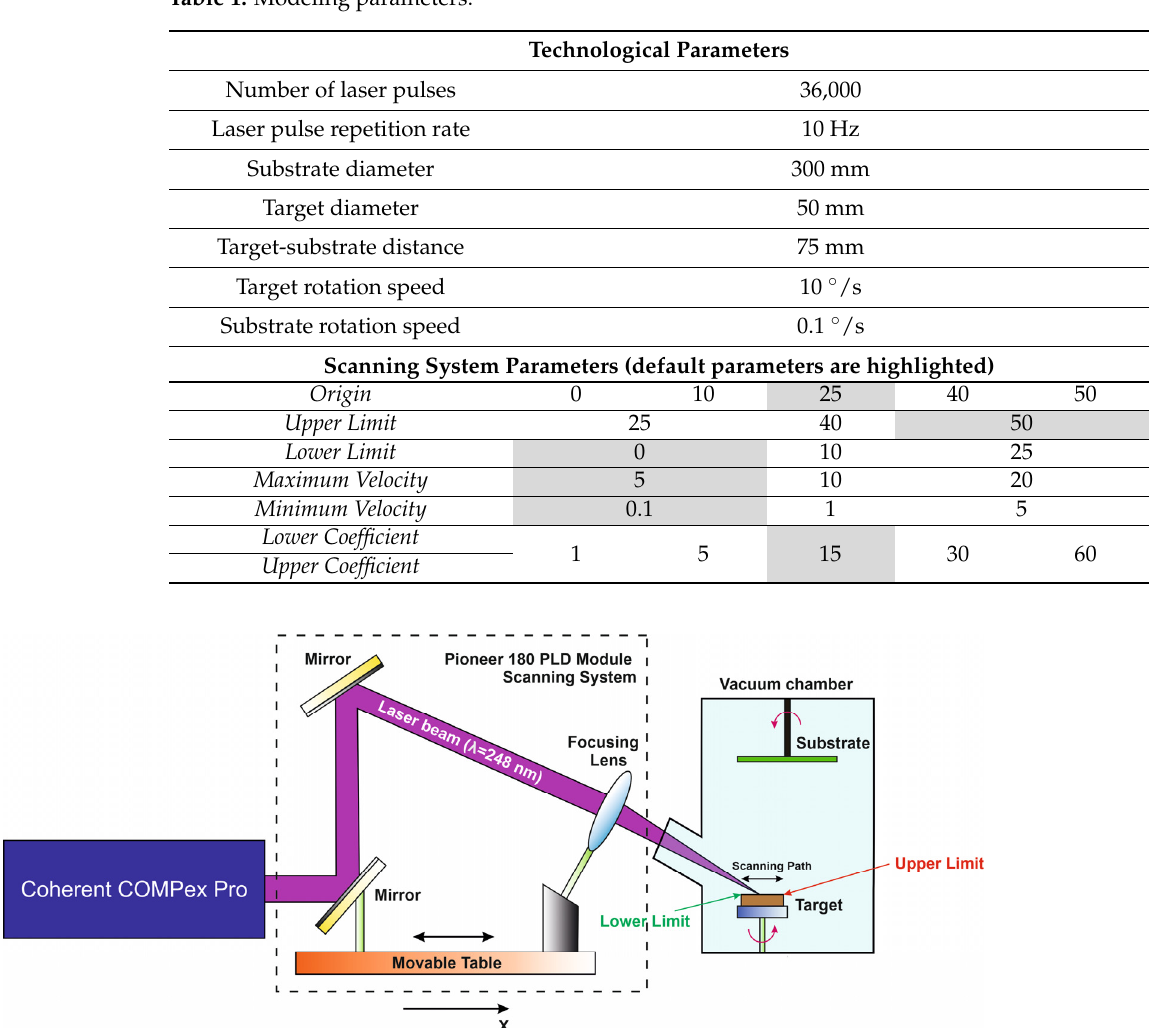
Table 1. Modeling parameters.